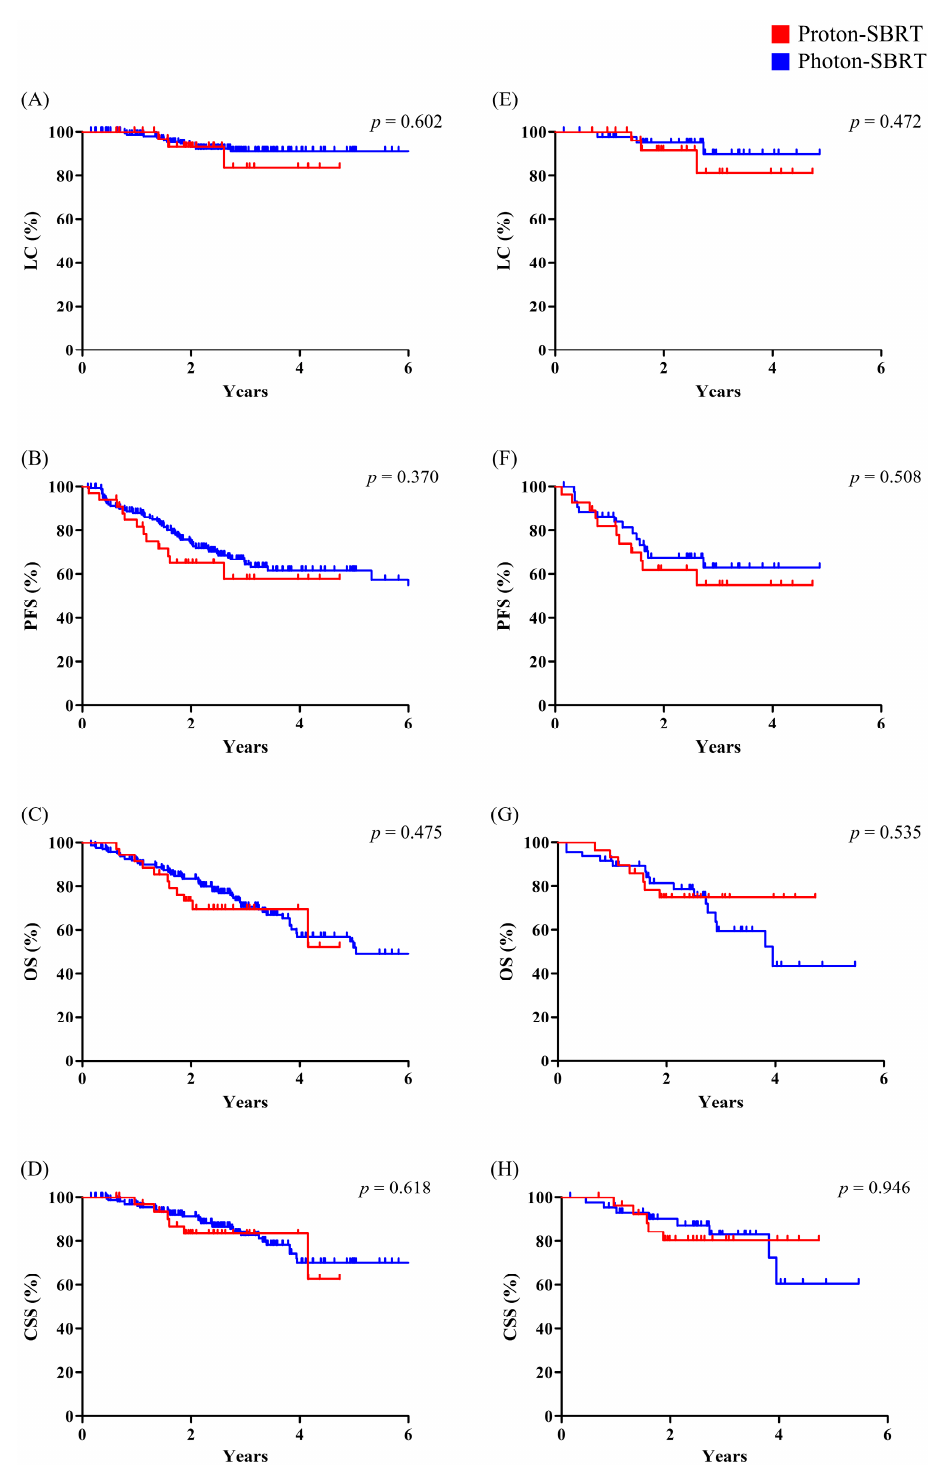
Figure 2. Comparison of clinical outcomes between proton SBRT and photon SBRT. ( A – D ) Entire cohort; ( E – H ) matched cohort. SBRT, stereotactic body radiation therapy; LC, local control; PFS, progression-free survival; OS, overall survival; CSS, cause-specific survival. In the entire cohort, there was no statistically significant difference in any of the clin ‐ ical outcomes following either technique: LC ( p = 0.602), PFS ( p = 0.370), OS ( p = 0.475), or CSS ( p = 0.618). These findings were also similar in the matched cohort: LC ( p = 0.472), PFS ( p = 0.508), OS ( p = 0.535), and CSS ( p = 0.946) (Figure 2).